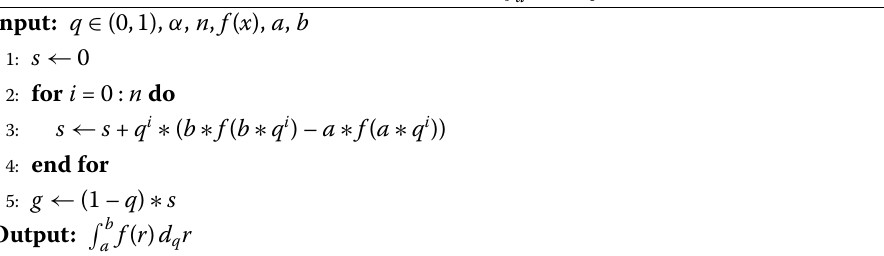
Algorithm 5 The proposed method for